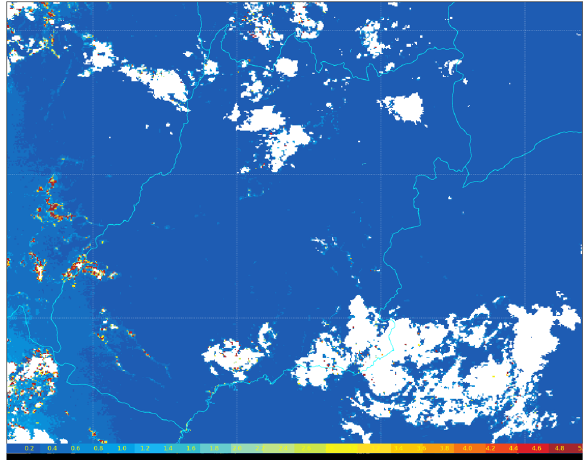
Figure 3. Image generated from aerosol readings for March 31, 2019 at 8:15 am (local time) In a t-test statistical analysis of independent group, considering the low aerosol groups ( AOD < 0 . 1 ) with 85 samples and the highest aerosol level ( AOD ≥ 0 . 1 ) with 23 samples, Box & Whisker graphs were generated to illustrate the sample distri- Figure 2. Image generated from aerosol readings for March 31, bution of the two aerosol groups as shown in Figure 6. Higher 2019 at 6:45 am (local time) values of electric voltage are observed as aerosol increases, as well as higher values of electric current and electric power, as aerosol decreases. The generated voltage averages 178.16 V ( σ = 6 . 82 ) for low aerosol level and 182.56 V ( σ = 6 . 89 ) for higher aerosol level ( F = 1 . 01 , df = 106 , p < 0 . 05 ). On the other hand, the av- erage current generated was 6.75 A ( σ = 1 . 81 ) for low aerosol level and 5.31 A ( σ = 2 . 46 ) for higher aerosol level ( F = 1 . 84 , df = 106 , p < 0 . 05 ). Indeed, the average power of 39.36 W ( σ = 5 . 14 ) for low aerosol level and 37.52 W ( σ = 5 . 48 ) for higher aerosol level ( F = 1 . 13 , df = 106 , p < 0 . 05 ). The av- erage low aerosol temperature was 38.48 °C ( σ = 4 . 93 ) and the highest aerosol level was 37.52 °C ( σ = 5 . 94 ), not presenting statistical difference between the groups ( F = 1 . 45 , df = 106 , p = 0 . 23 ). The results confirm that even in a short time ob- servation it is possible to identify differences in the photovol- taic solar energy generation of solar panels according to aerosol